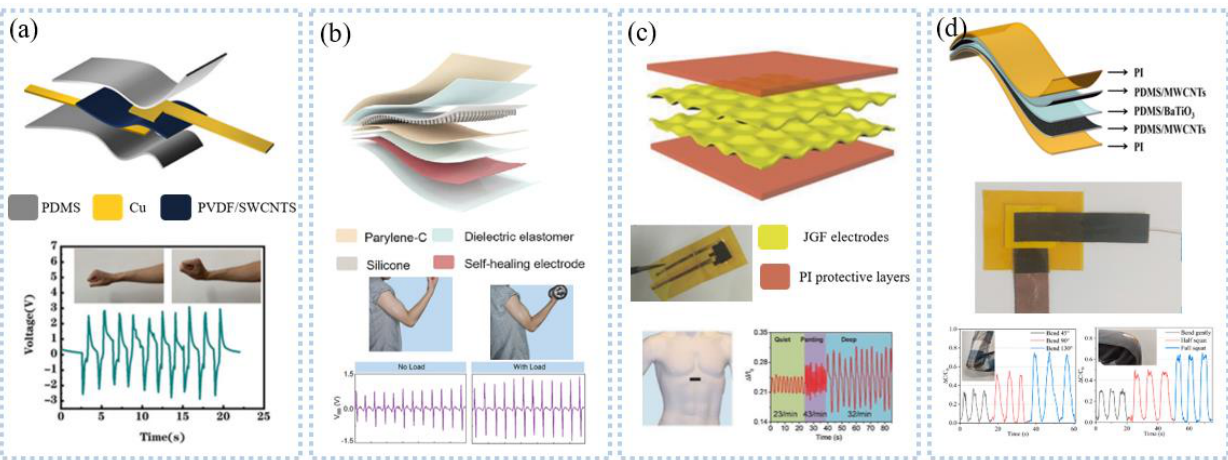
Figure 6. Body motion detection: ( a ) piezoelectric sensors for monitoring wrist movements. Reprinted with permission from Refs. [77]. Copyright 2021 Elsevier, ( b ) tribological sensor for monitoring upper arm muscle action. Reprinted with permission from Refs. [78]. Copyright 2021 American Chemical Society, ( c ) piezoresistive sensor for monitoring breathing. Reprinted with permission from Refs. [79]. Copyright 2018 John Wiley and Sons, and ( d ) capacitive sensor for monitoring joint action. Reprinted with permission from Refs. [80]. Copyright 2021 MDPI.